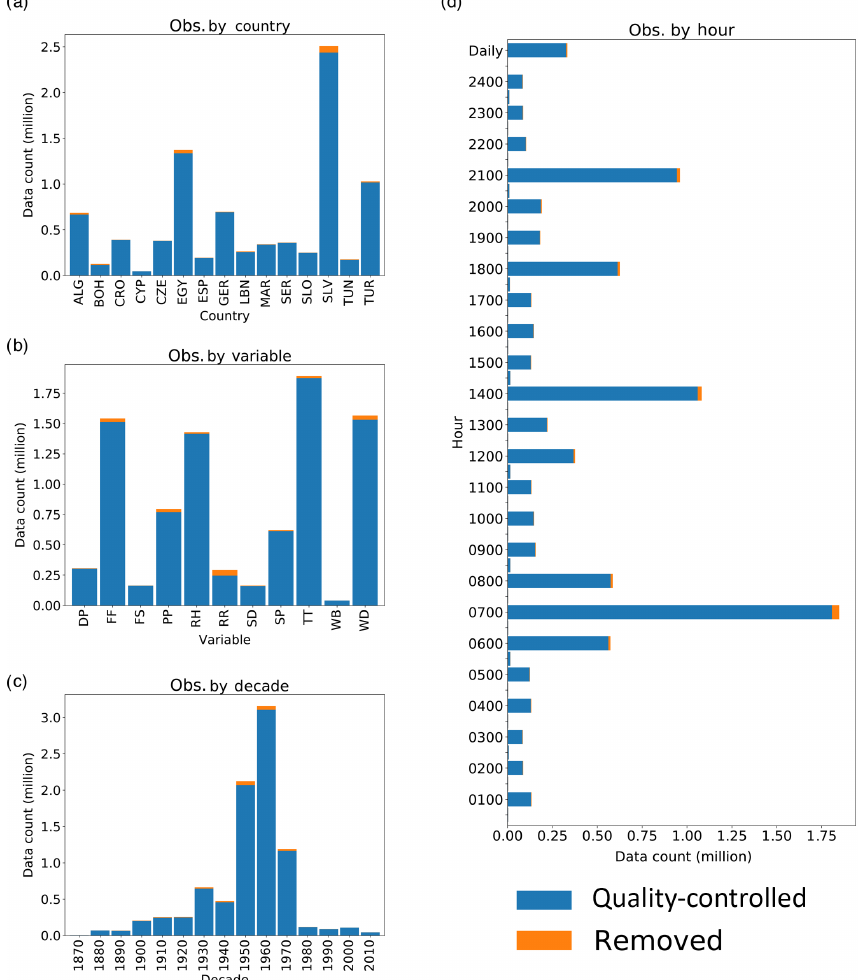
Figure 8. Distribution of the digitised observations by (a) country, (b) variable, (c) decade and (d) hour of observation. The length of each bar shows the number of observations digitised (in millions), with orange indicating any observations flagged and removed during SAQC. Variable acronyms are as those described in Table 1. Country codes are as those listed in Table